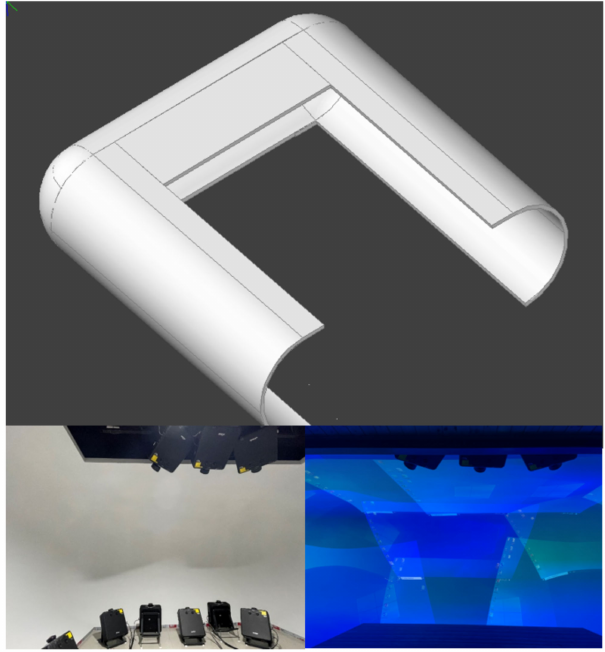
Figure 9. Projection environment of capsule-like curtain.